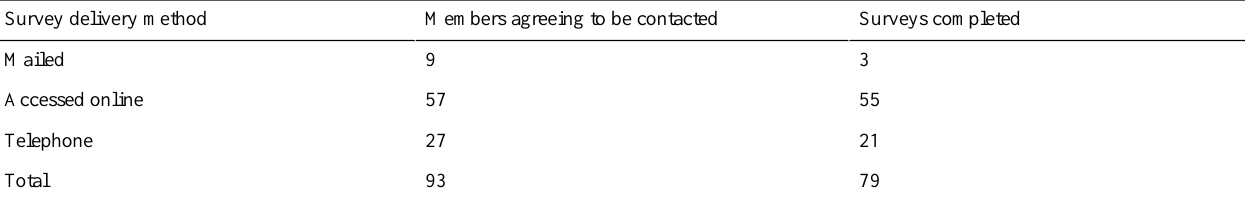
Table 1. Responses to the